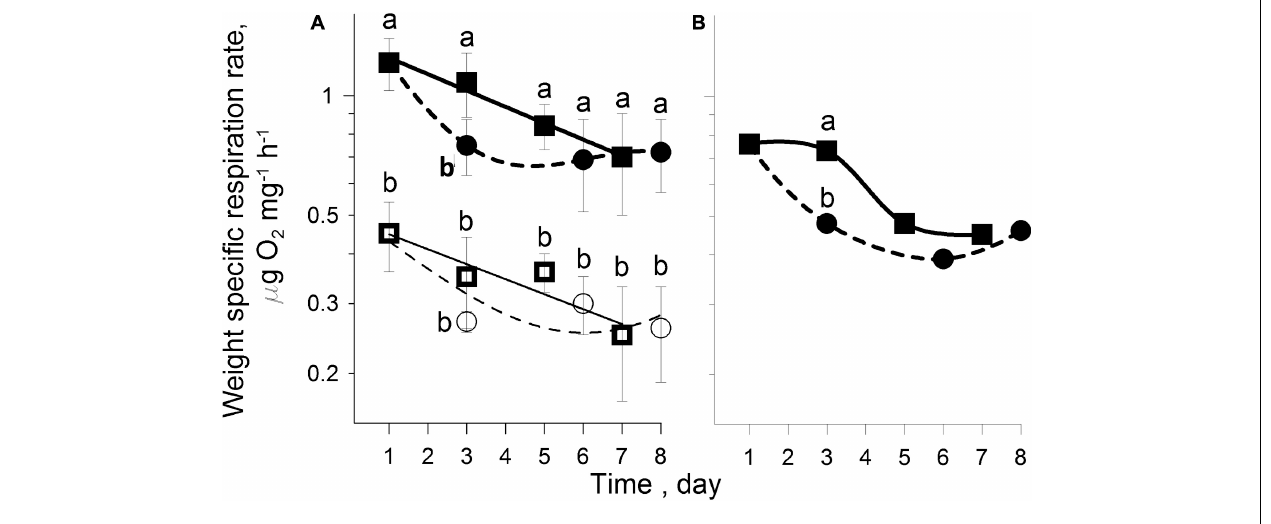
FIGURE 7 | (A) Temporal changes in active ( • ) and anesthetized ( ◦ ) WRR of females that consumed 6 µ m microplastics and active ( (cid:4) ) and anesthetized ( (cid:3) ) WRR of starved females (Treatments RESP3 and RESP4); (B) : Temporal changes in scope of activity of microplastic ingesting ( • ) and starved ( (cid:4) ) females. [Low-case letters (a,b) denote significant variable differences between each active and anesthetized groups using Duncan’s Multiple Range test, P < 0.05].